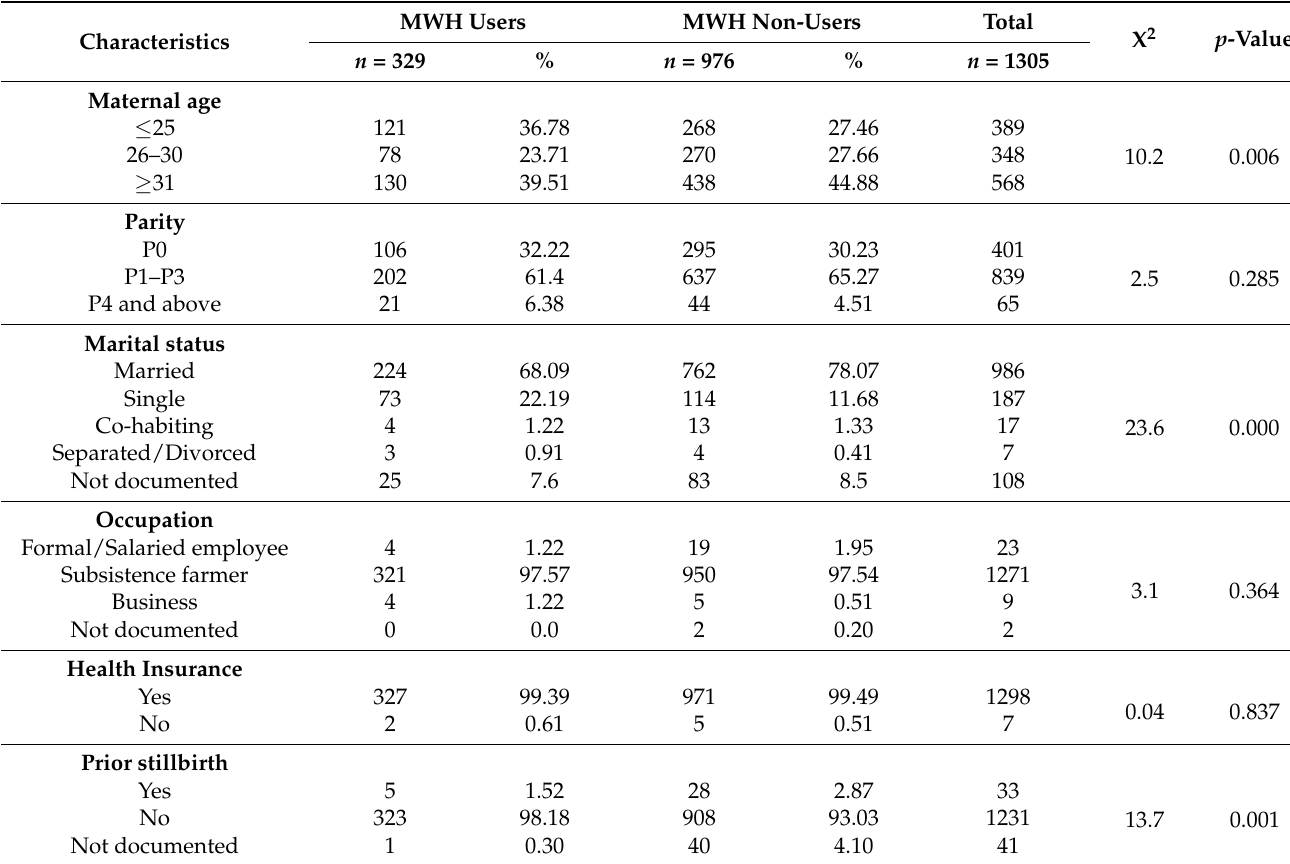
Table 2. Characteristics of women (MWH-users versus